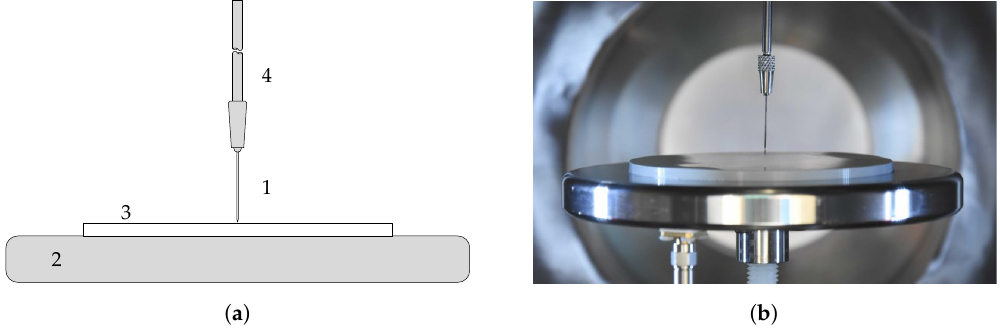
Figure 1. Needle-plane electrode configuration with a disc-shaped insulator sample: ( a ) Two-dimensional illustration of the configuration with the following numbered features: 1-needle electrode, 2-plane electrode, 3-disc-shaped insulator sample and 4-needle holder; ( b ) Actual picture of the practical test configuration as set-up inside the pressure